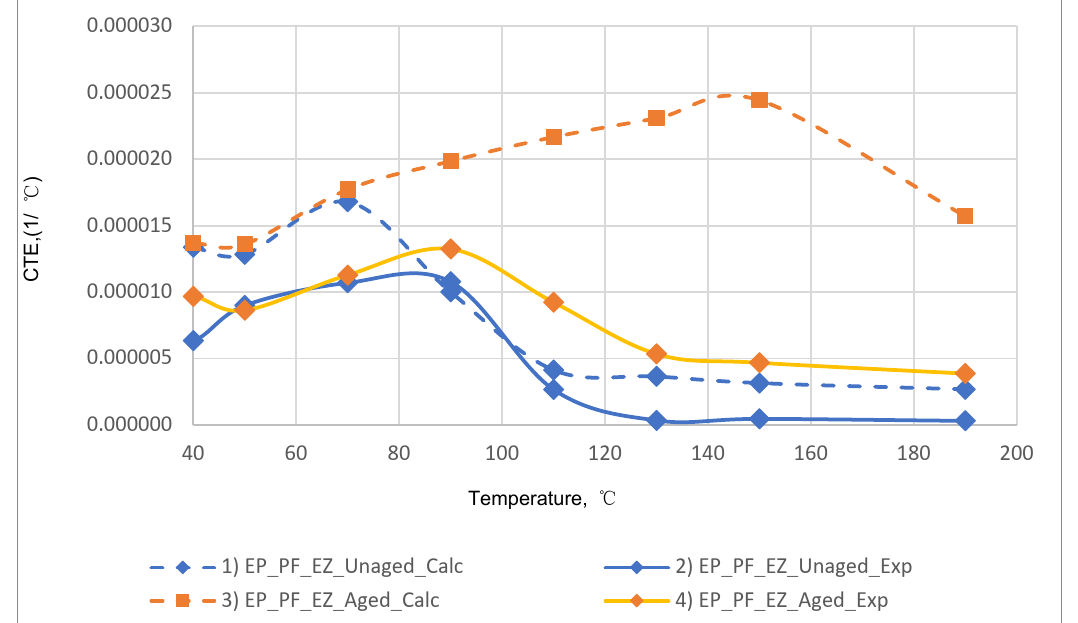
Figure 17. Temperature dependence of CTE for epoxy-phenolic fiberglass on EZ-200 fiberglass fabric: (1) calculated for EP-PF-EZ200; (2) experimental for EP-PF-EZ200; (3) calculated for EP-PF-EZ200-TA; (4) experimental for EP-PF-EZ200-TA.